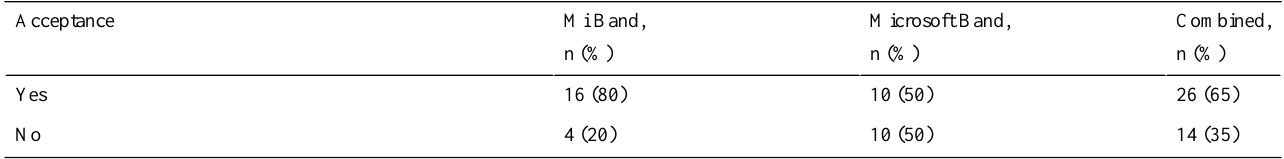
Table 4. Acceptance per device.